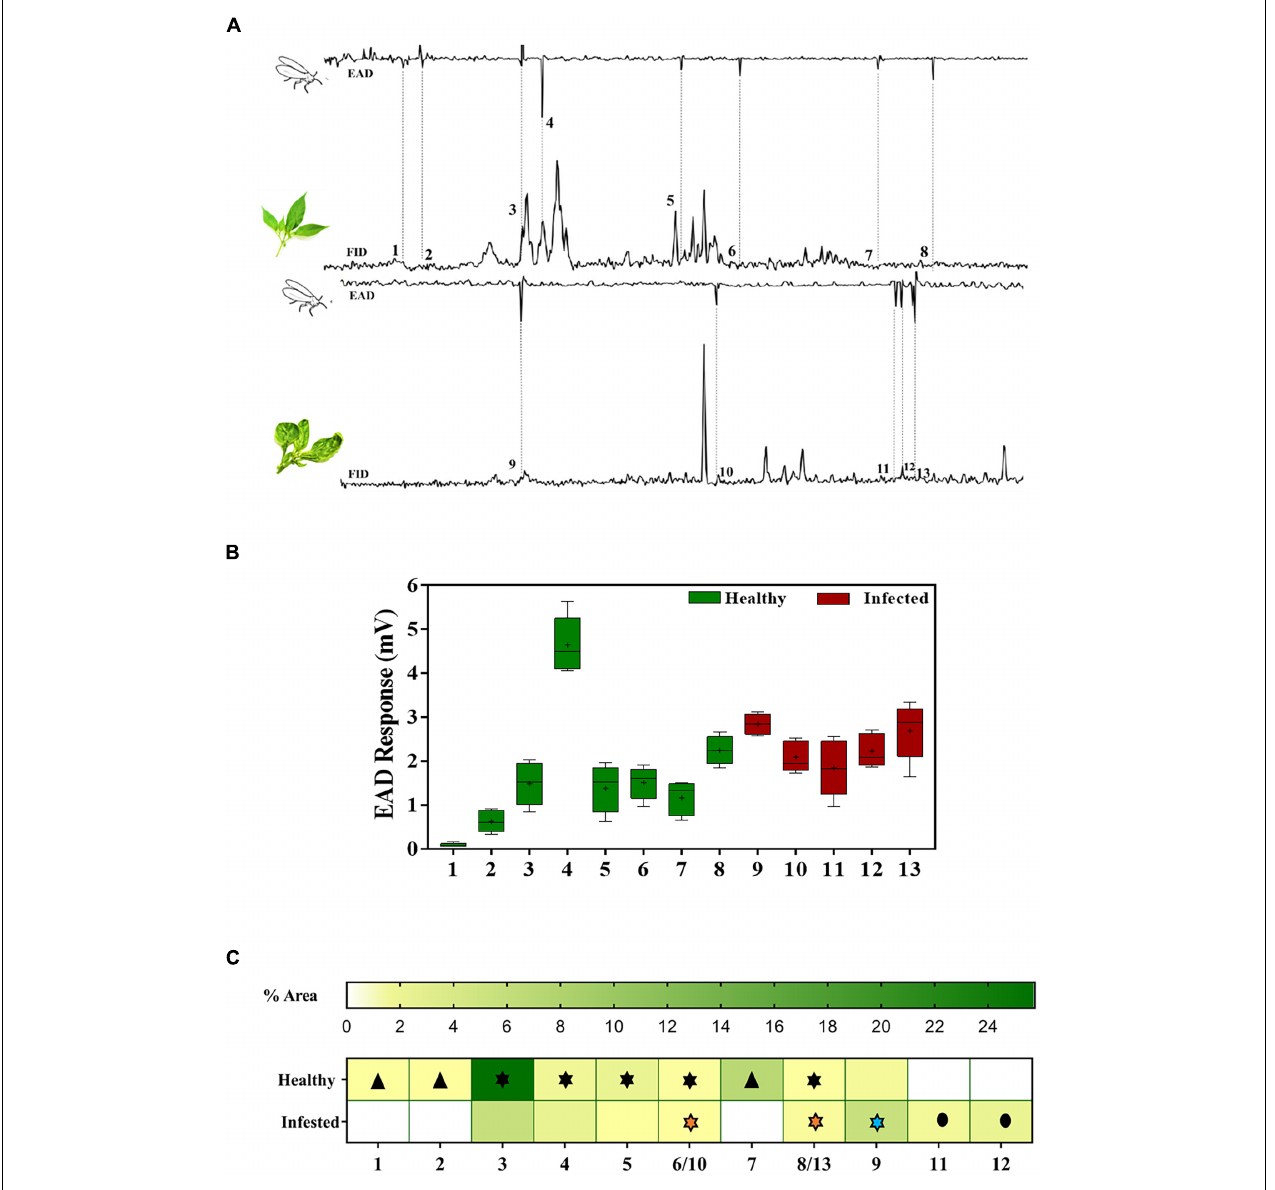
FIGURE 4 | Antennal response of non-viruliferous B. tabaci to healthy and infected chili volatiles. (A) Representative GC-EAD trace showing EAD active peaks. (B) Box and Whisker plot showing the compounds that elicited antennal response. (C) Heat map showing the differences in the volatile emissions of chili plants under different treatments. “ ” – indicates antennal response to compounds exclusively present in healthy plant volatiles; “ ” – indicates antennal response to compounds (with varied concentrations) from “healthy,” “healthy/infected” and “infected” plant volatiles, respectively; “ ” – indicates the antennal response to compounds exclusively present in infected plant volatiles. Serial numbers in the x -axis of (A–C) correspond to EAD active chemical compounds and given here [(1) Butanoic acid, 2-ethyl-2- methyl-, methyl ester; (2) 2,3,4 Trimethyl hexane; (3) n-Undecane; (4) 1-octanol-3, 7 dimethyl; (5) 2,6,11 Trimethyl dodecane; (6,10) Methyl eugenol; (7) Phytane; (8,13) Heptadecane 2,6,10,15, tetramethyl; (9) Dodecane; (11) 3,4,5 Trimethoxy benzaldehyde; (12)